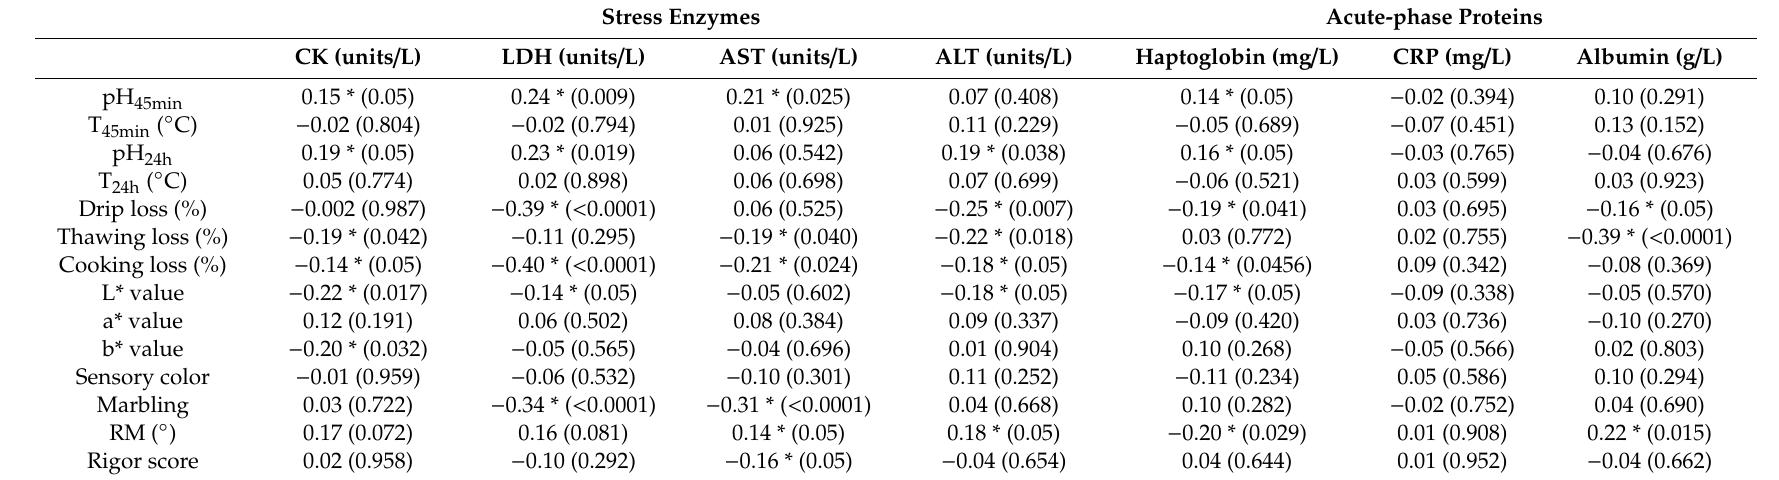
Table 6. Correlations (r) between stress enzymes, acute-phase proteins, and meat quality traits in slaughter pigs. Stress